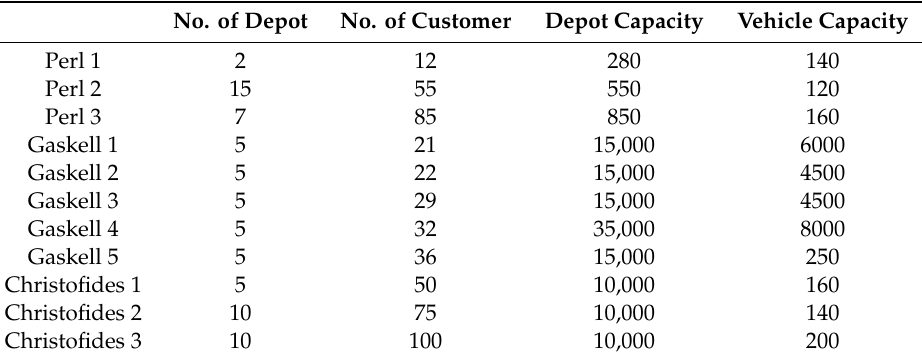
Table 2. Characteristics of Perl, Gaskell, and Christofides